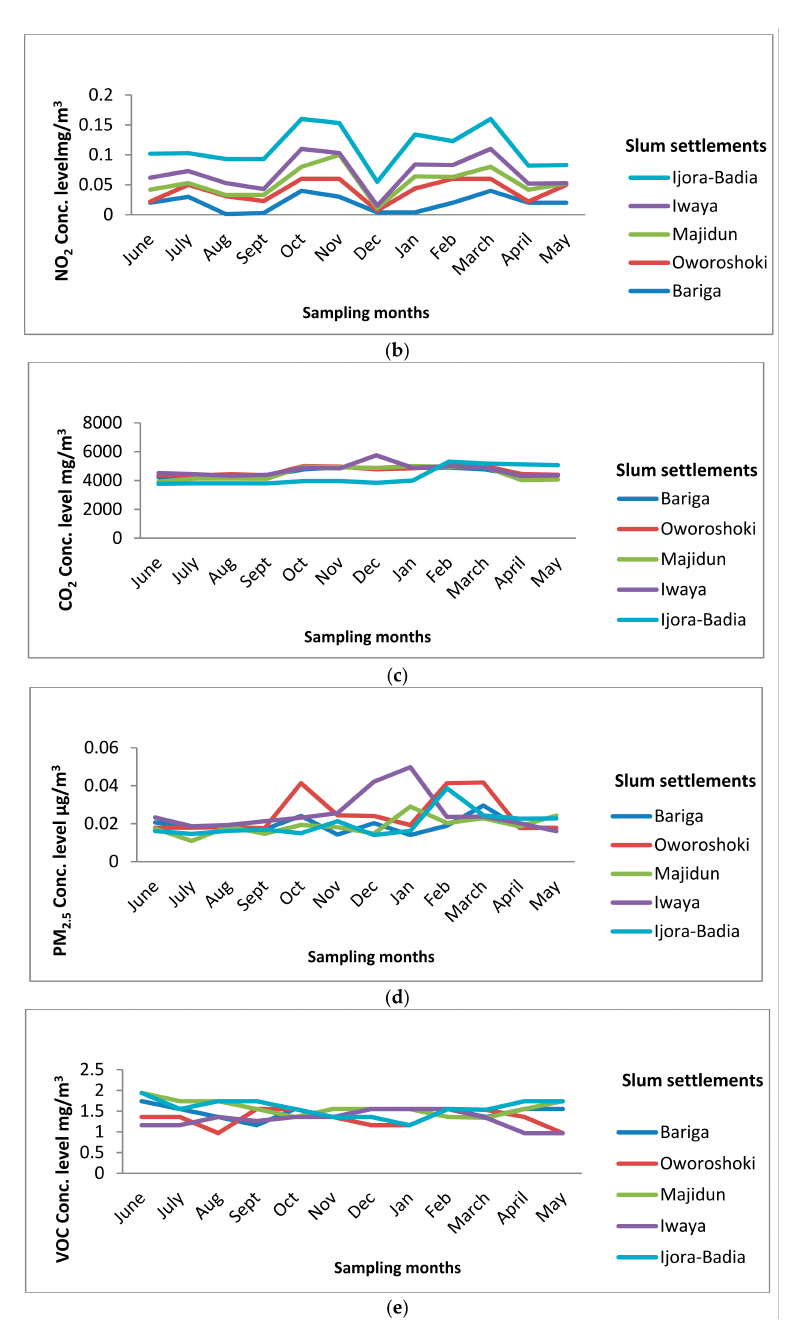
Figure 3. Concentrations of air pollution across the slum communities during the 2018–2019 sampling period. ( a ) Trend pattern of SO 2 concentrations in the selected slum settlements during 2018–2019, showing two slum settlements with pollutant increments at the peak both in the wet and dry seasons. ( b ) Concentrations of NO 2 in the selected slum settlements during 2018–2019 showing four slum settlements with pollutant increments at the peak both in the wet and dry seasons, while one of the settlements shows a decreasing pattern. ( c ) CO 2 concentration in the five selected slum settlements during 2018–2019 showing that all the slum settlements have the same trend pattern of pollutants both in the wet and dry seasons. ( d ) Trend pattern of particulate matter (PM 2.5 ) concentration during 2018–2019 showing that two of the slum settlements had a similar trend pattern both in the wet and dry seasons compared to the other slum settlements. ( e ) Concentrations of VOC pollutants in the selected slum settlements showing a similar pattern of pollution emissions during the wet and dry seasons from 2018 to